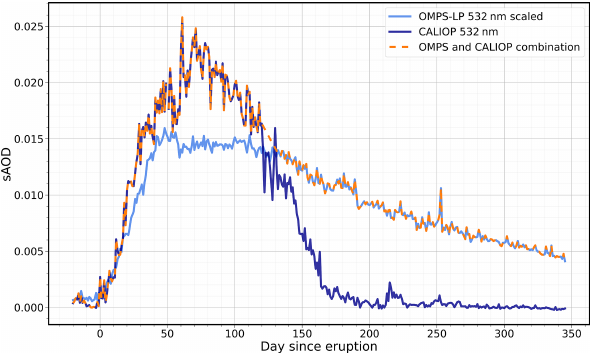
Figure 5. Daily perturbation in the sAOD averaged over 30–90 ◦ N as observed by OMPS-LP scaled from 510 to 532nm (light blue) and CALIOP at 532nm (dark blue). The dashed orange line rep- resents the combined OMPS-LP and CALIOP dataset at 532nm. We remove the long-term background sAOD derived from OMPS- LP (0.0041) and CALIOP (0.0003) for the years 2013–2018 from those for 2019 to provide a stratospheric perturbation for the obser-